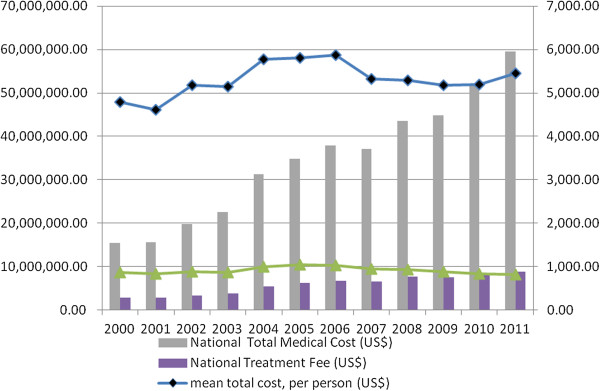
Annual national hospitalization costs and averaged individual hospitalization costs of admitted PAD cases in Taiwan from 2000 to 2011.